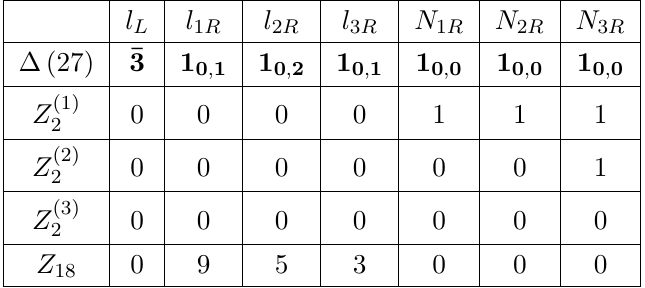
× Z (2) × Z (3) × Z 18 . Superscripts differentiate 2 2 2